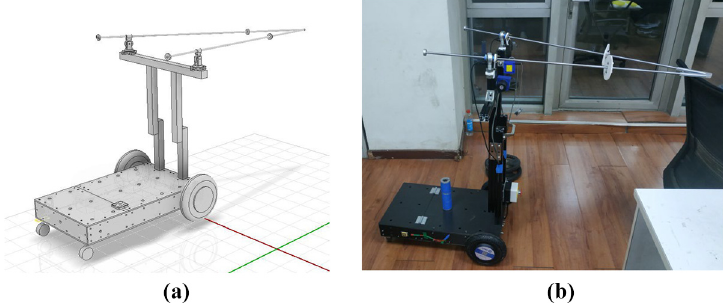
Figure 6 The design of a person-following robot in the experiment: (a) the PFR model; (b) the PFR in the experiment